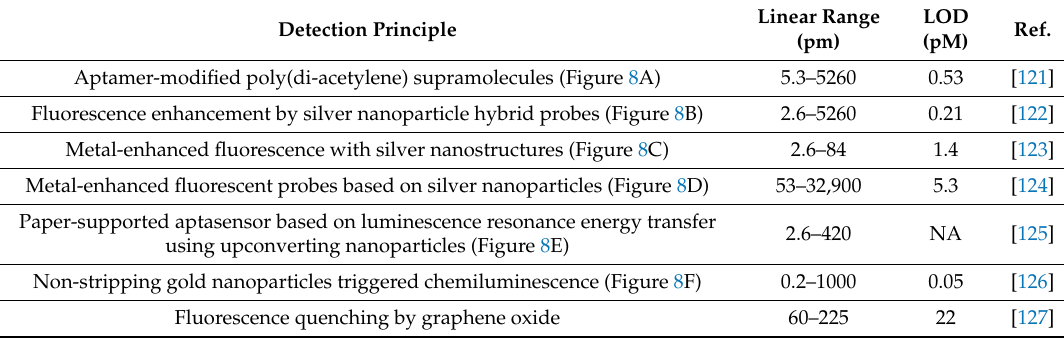
Table 10. Analytical parameters of heterogeneous fluorescent assays for IgE